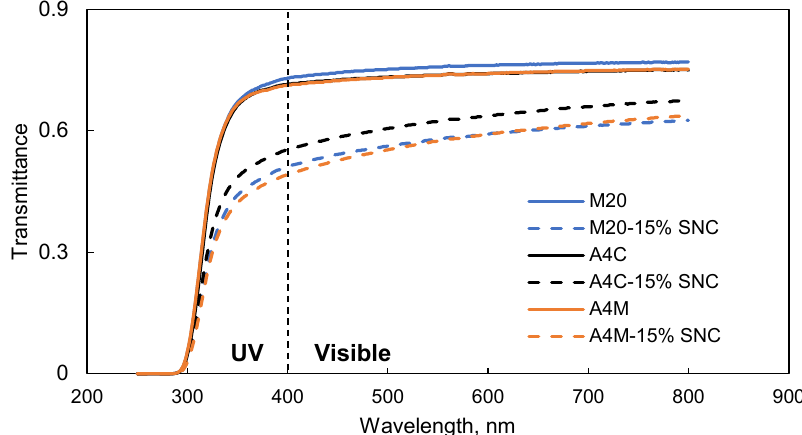
Figure 7. Light transmittance of MC films and MC-SNC nanocomposite films.